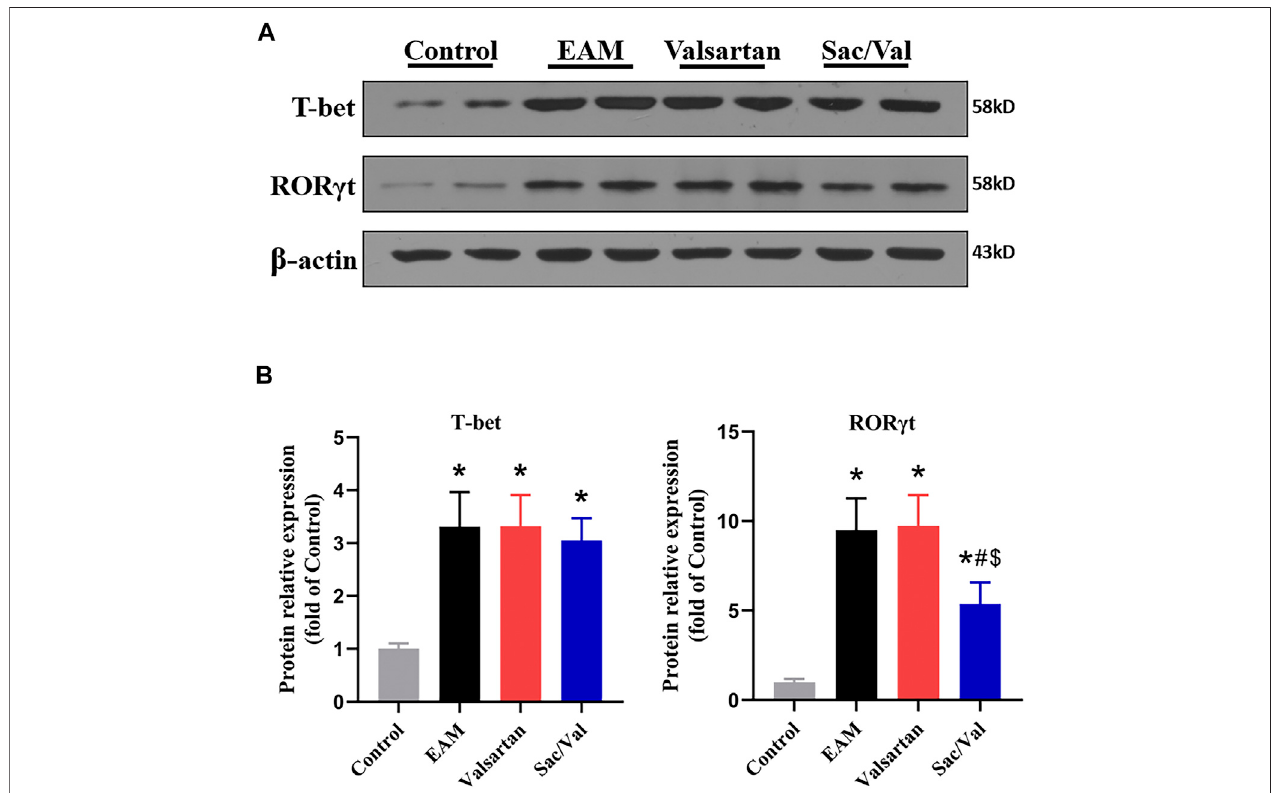
FIGURE4| Sac/ValloweredlevelsofROR γ tinmyocardialtissue. (A) RepresentativewesternblottingresultsforcardiacT-betandROR γ t. (B) Thestatisticalgraph of the western blotting results. All experiments had six mice per group and data were expressed as means ± SEM and analysed by one-way ANOVA. * p < 0.05 vs. Control group; # p < 0.05 vs. EAM group; $ p < 0.05 vs. Valsartan